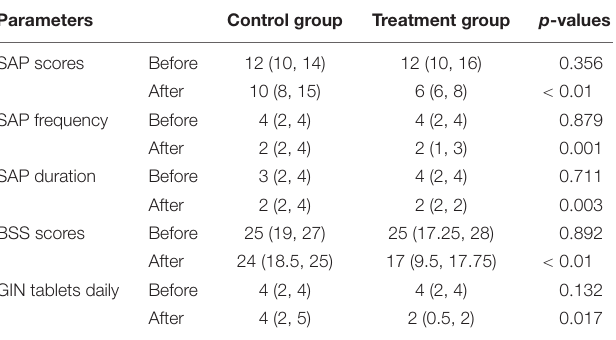
TABLE 8 | The comparison of the outcome of SAP, BSS, and GIN use between two groups.